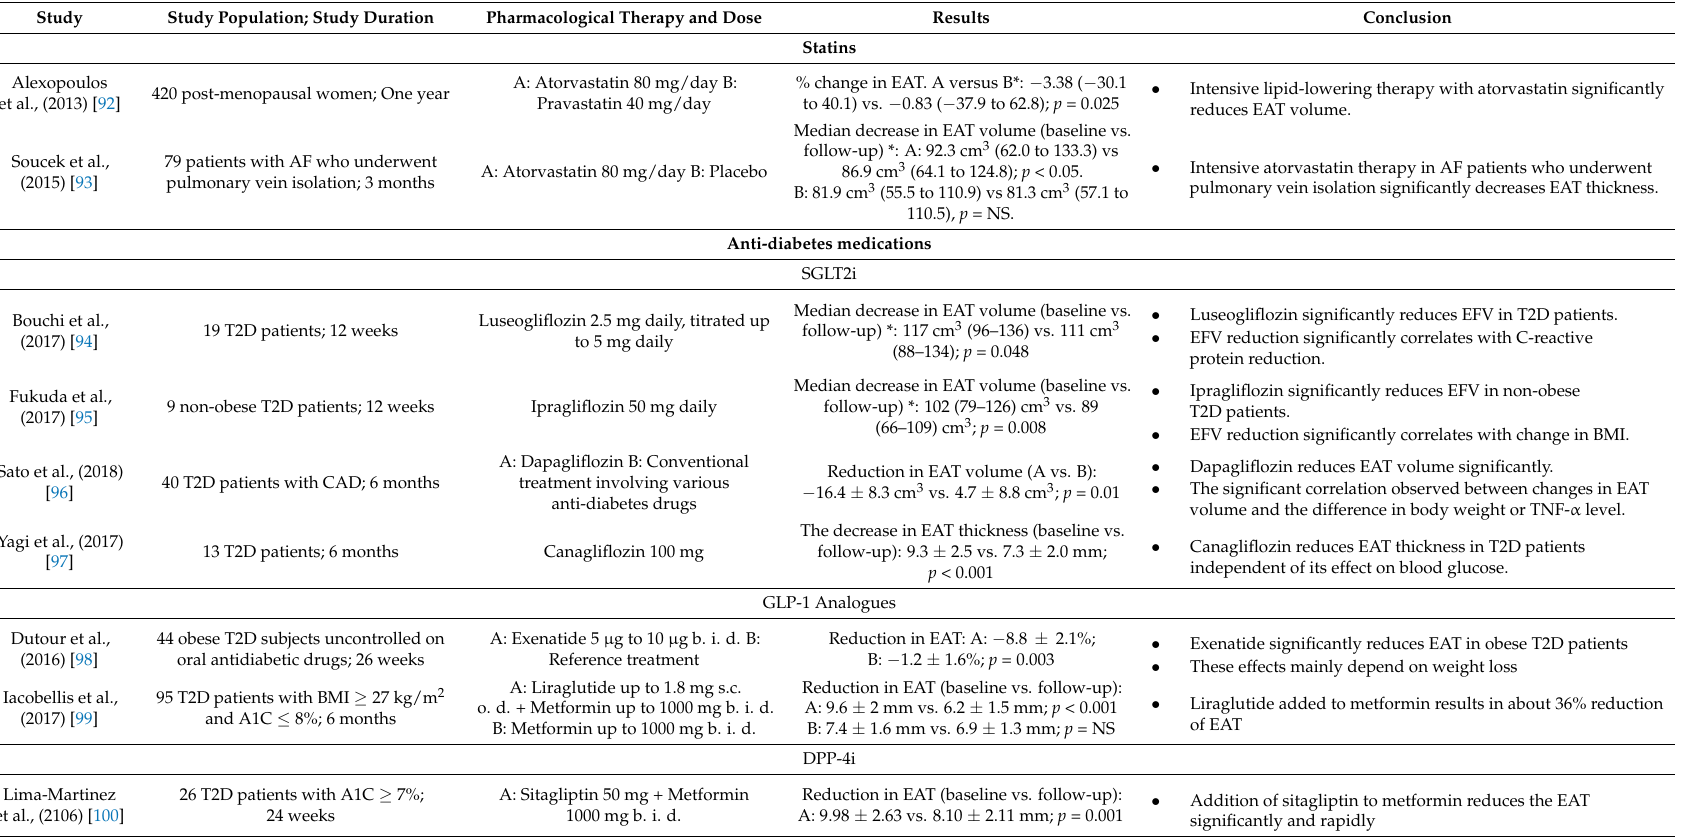
Table 3. Evidence indicating the reduction of EAT with pharmacological